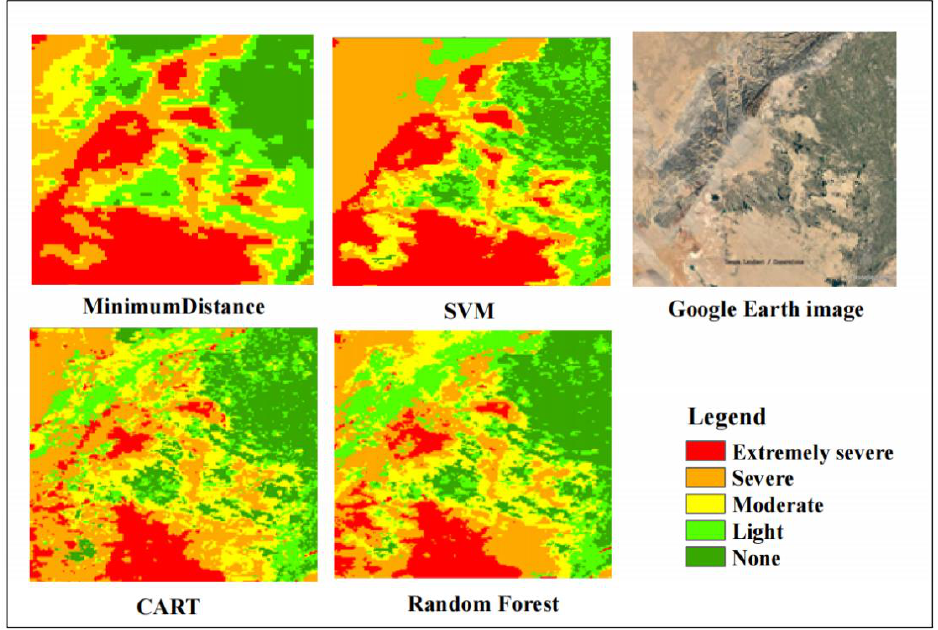
Figure 5. Classification results of different machine learning models for a typical region. SVM stands for support vector machine and CART stands for classification and regression tree.